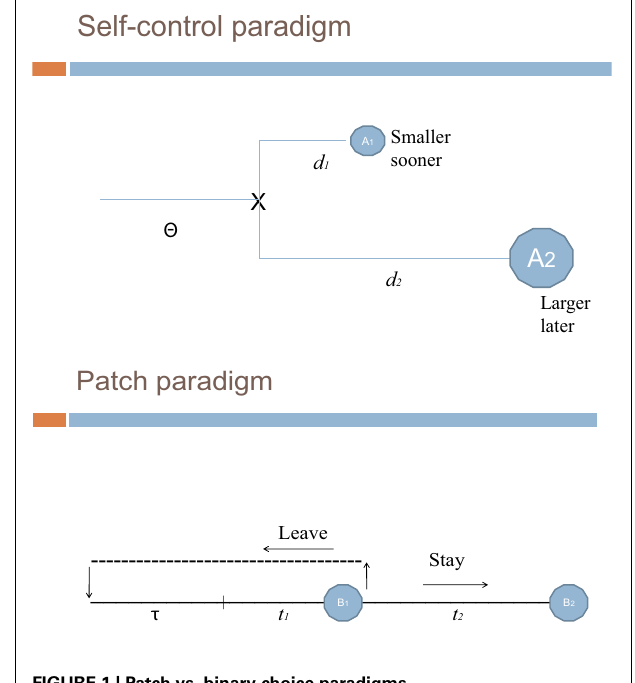
FIGURE 1 | Patch vs. binary-choice